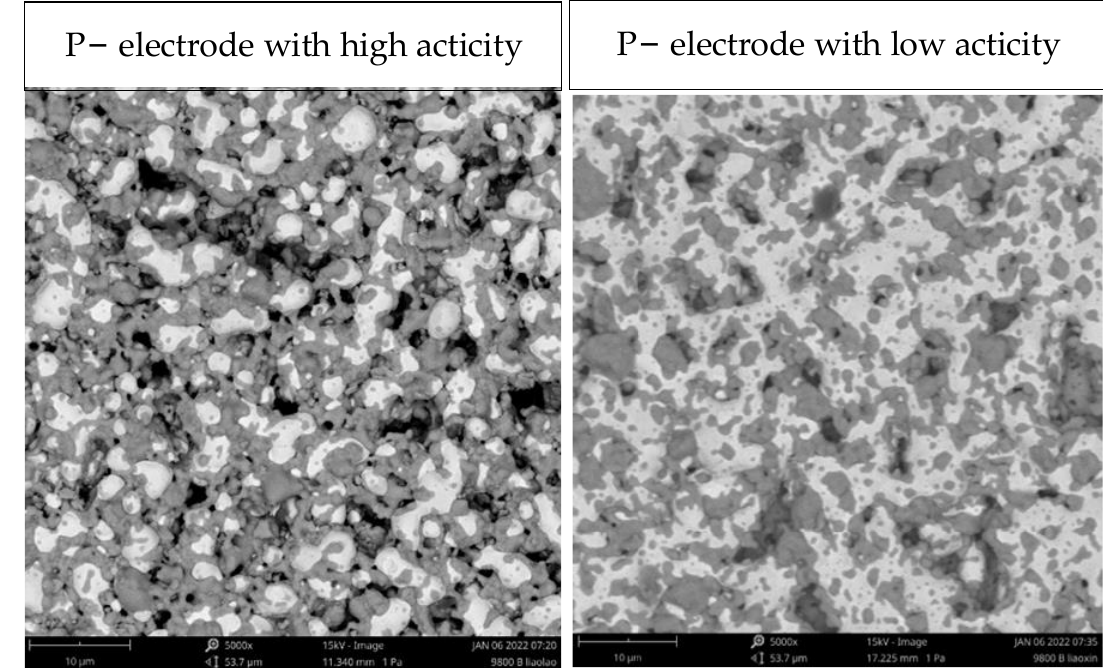
Figure 15. The structure of P− electrode with high and low activity.